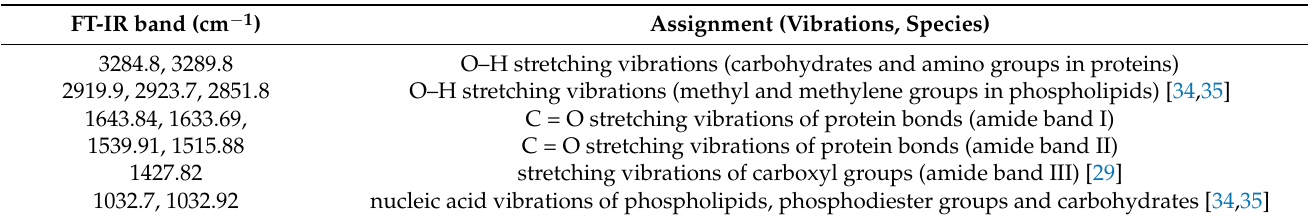
Table 2. FT-IR peaks of BG residues.